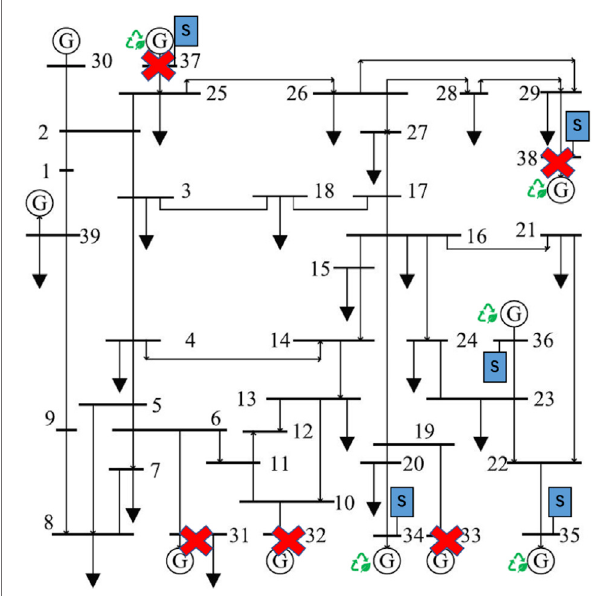
FIGURE6| Thepower networkwithpower storage nodesbasedonthe IEEE 39-Bus system for case 2.